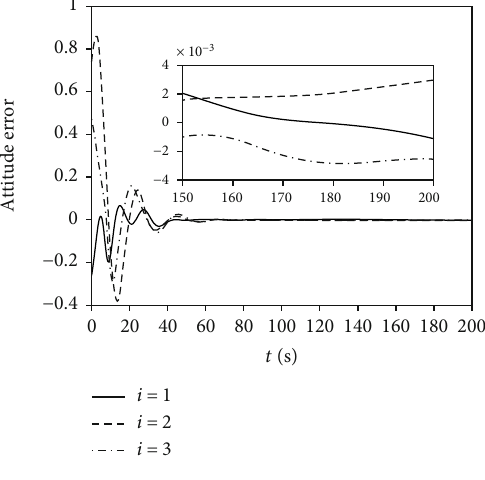
Figure 2: Attitude tracking error using the fi nite-time